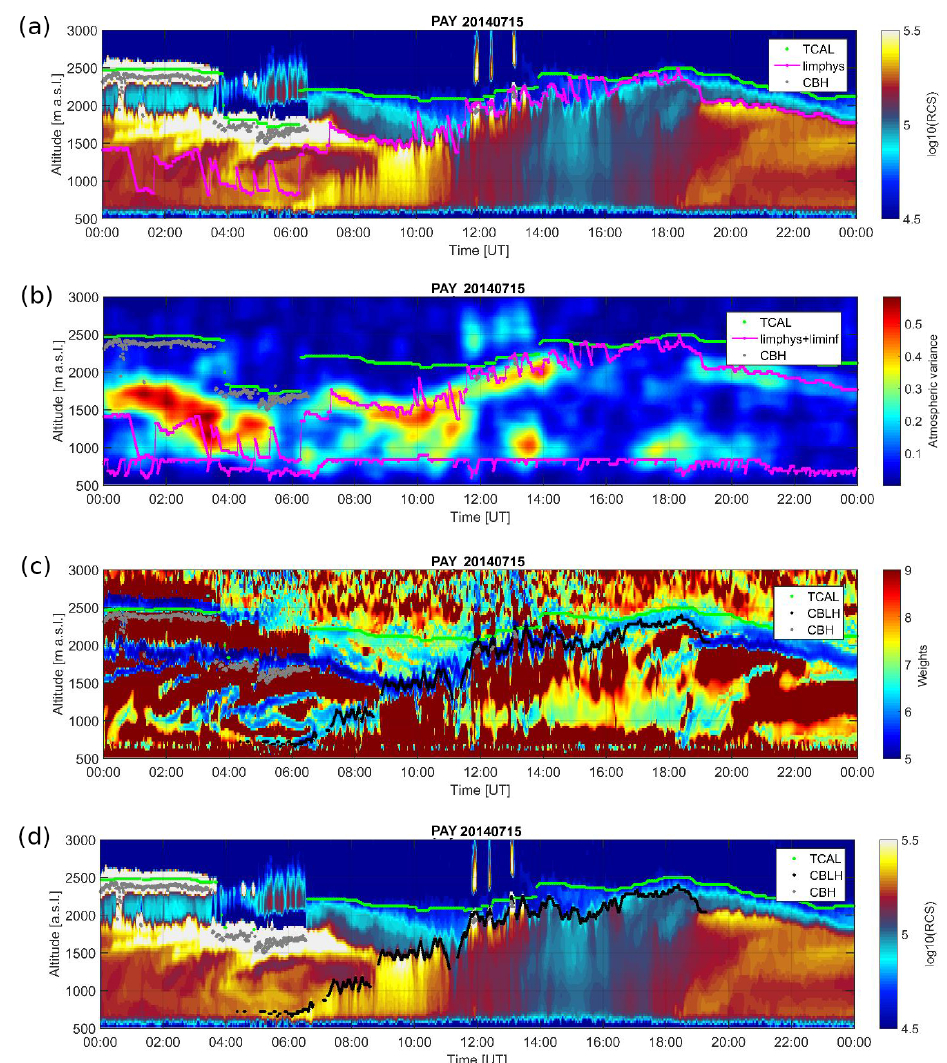
Figure 2. Time series of the different processing steps of the PathfinderTURB for 15 July 2014 at PAY. (a) Time series of log10( S) with superimposed TCAL, CBH and limphys for altitude. (b) Time series of VAR (S) with superimposed CBH, limphys and liminf for altitude. (c) Time series of (cid:127)(t,z) with superimposed TCAL, CBH and retrieved CBLH (geodesic from sunrise to sunset). (d) Time series of log 10( S) with superimposed TCAL, the CBH and the retrieved